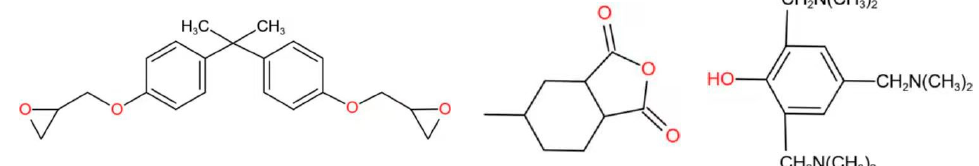
Figure 1. Molecular structures of components of epoxy resin.